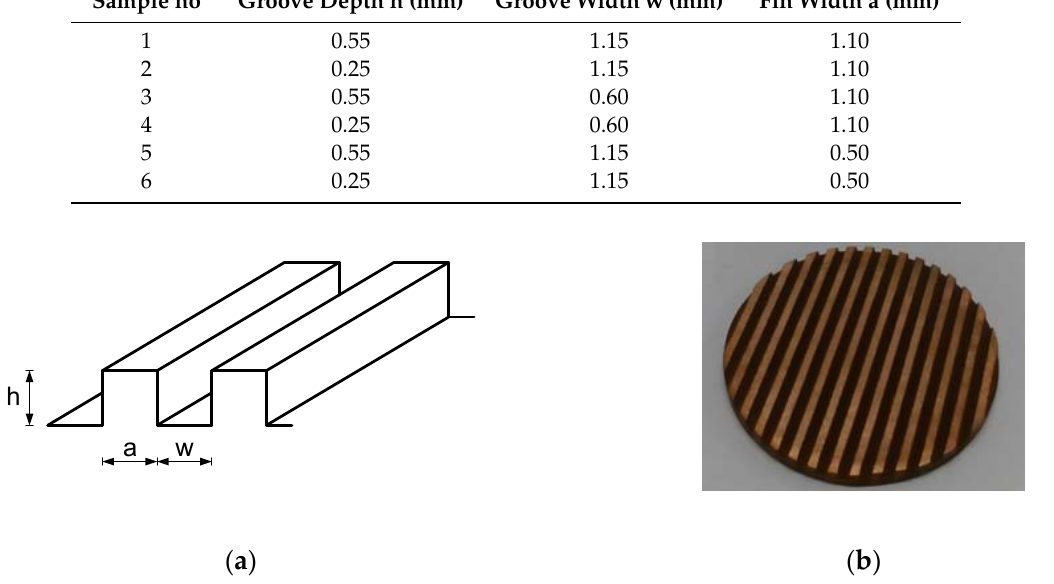
Figure 1. Laser treated sample. Schematic ( a ), picture of sample no 1 ( b ).